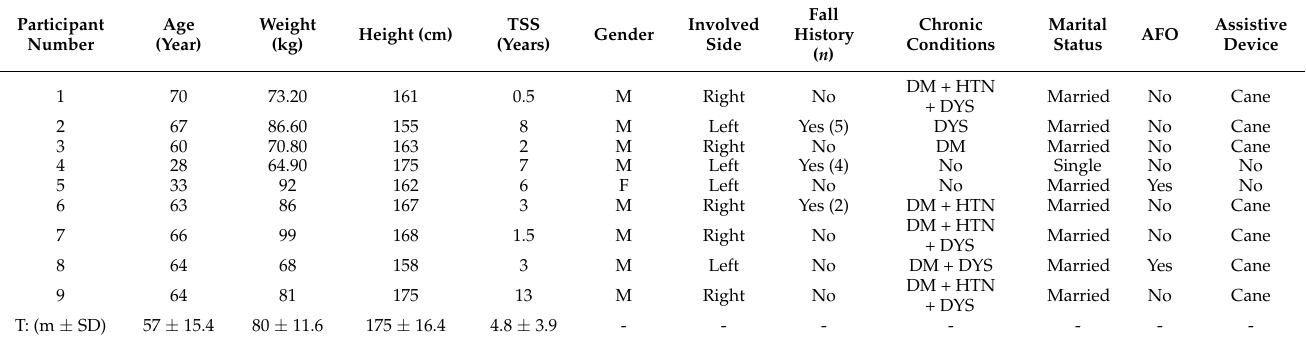
Table 1. The demographic characteristics of the participants ( n =